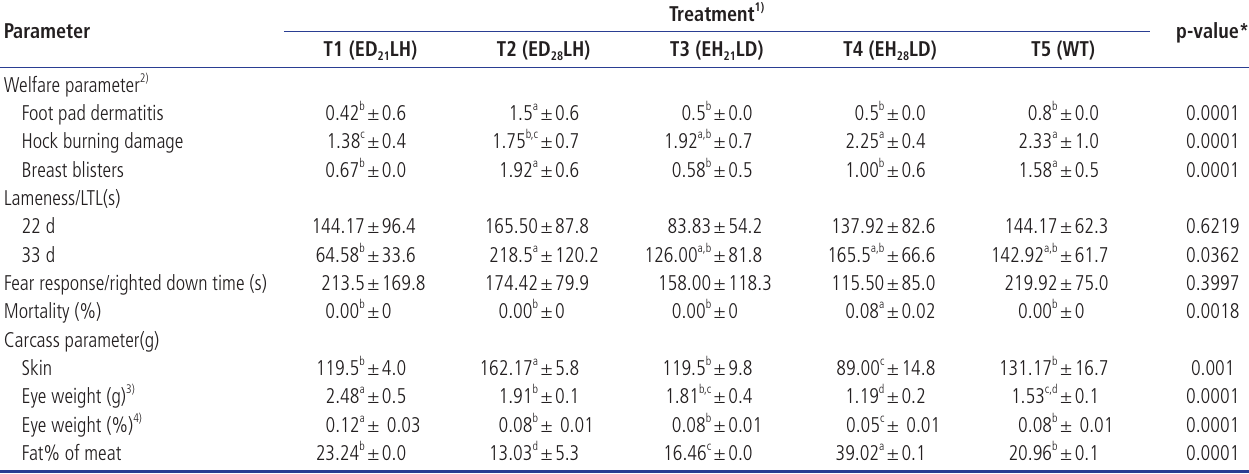
Table 2. Welfare and carcass parameters under different light intensity treatments